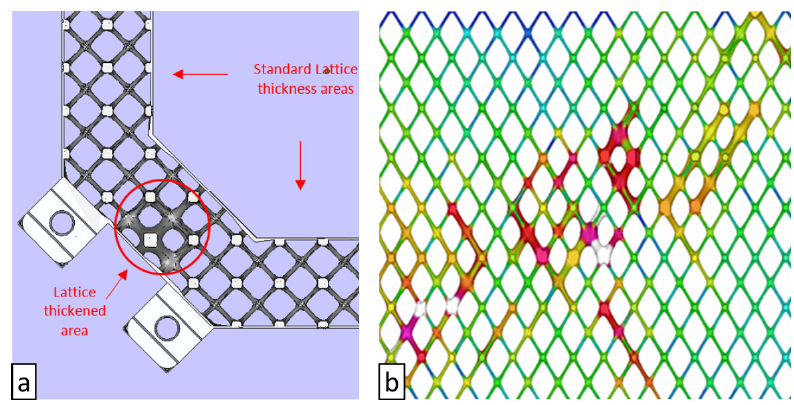
Figure 13. Example of local thickening ( a ) and multiple pass thickening ( b ).